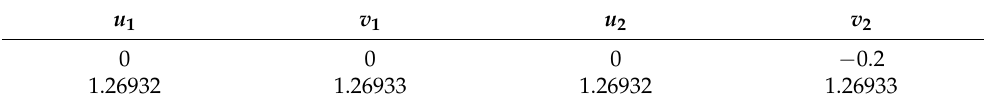
Table 1. The state variables in initial state and steady